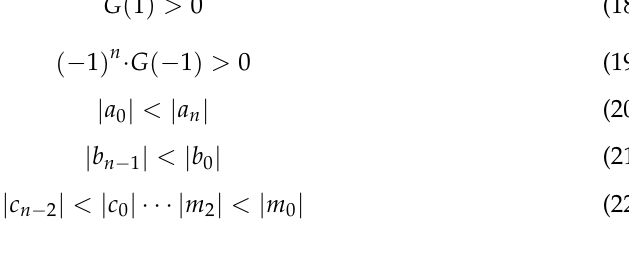
Table 2. Jury stability criterion for the α – β – γ